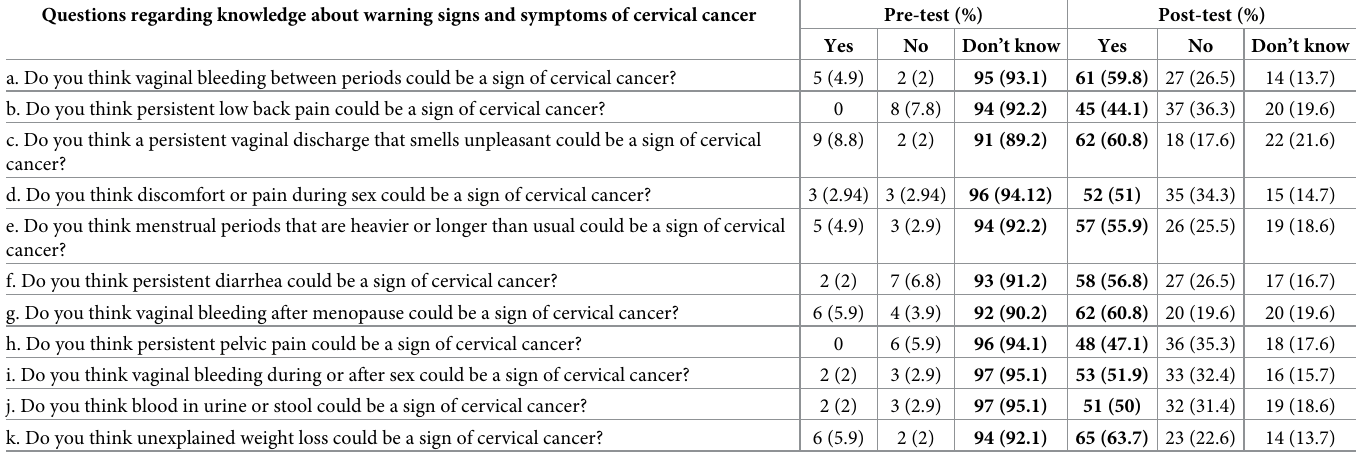
Table 1. Comparison of responses from participants before and after intervention regarding warning signs and symptoms of cervical cancer (n = 102). Questions regarding knowledge about warning signs and symptoms of cervical